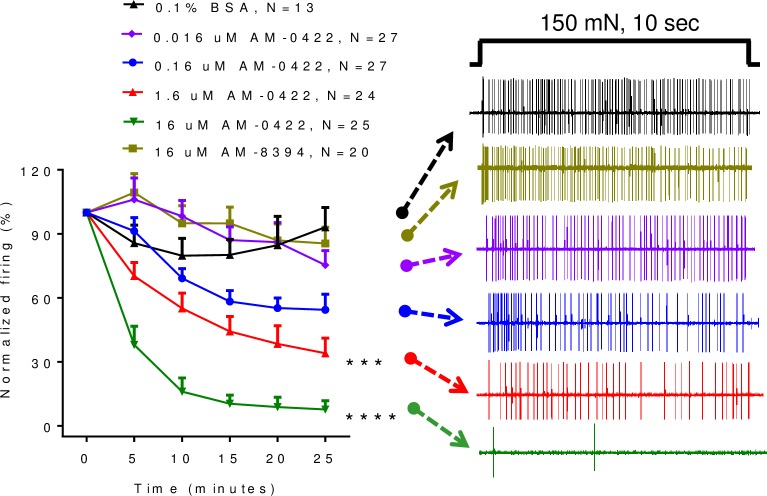
Inhibition of mechanically-evoked action potential firing in TTX-sensitive C-fibers by active peptide AM-0422 but not inactive peptide AM-8374.Time- and concentration-dependent inhibition of action potential firing by AM-0422. *** P < 0.001, **** P = 0.0001 by repeated measure two-way ANOVA with Dunnett’s multiple comparison test compared to 0.1% BSA vehicle. Representative traces for each group are shown for the 25 min time point on the right. 150 mN mechanical stimuli were applied for 10 sec every 5 min. Data are mean ± SEM; n = 13–27 fibers per group.